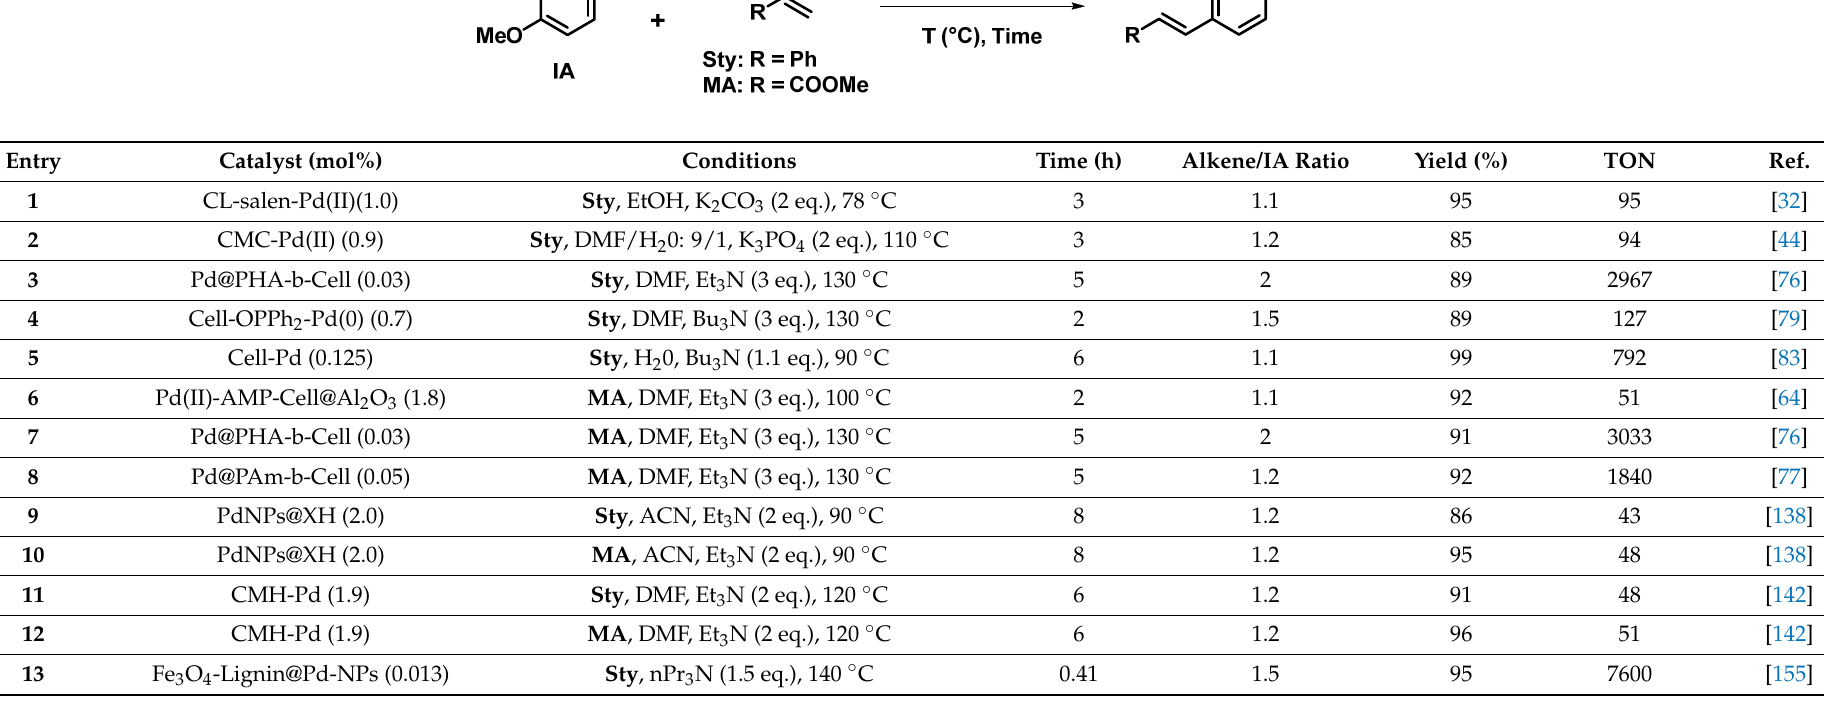
Table 2. Mizoroki–Heck cross-coupling reaction between 4-methoxyphenyl iodide and styrene (Sty) or methylacrylate (MA). Comparison of the reaction conditions and results from different articles.